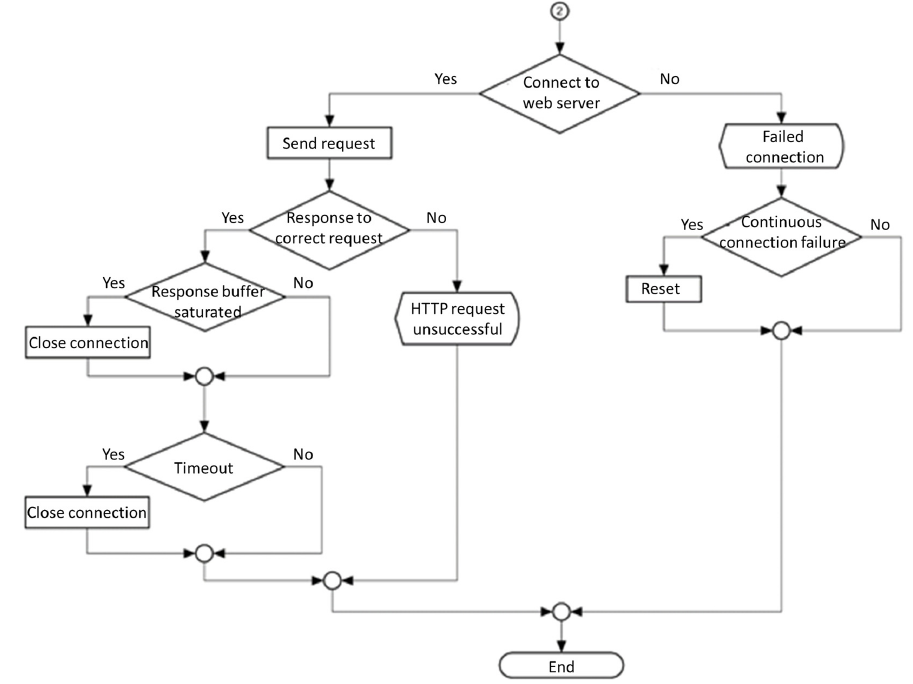
Figure 4. Instrumentation System Flow Chart—Part 2.